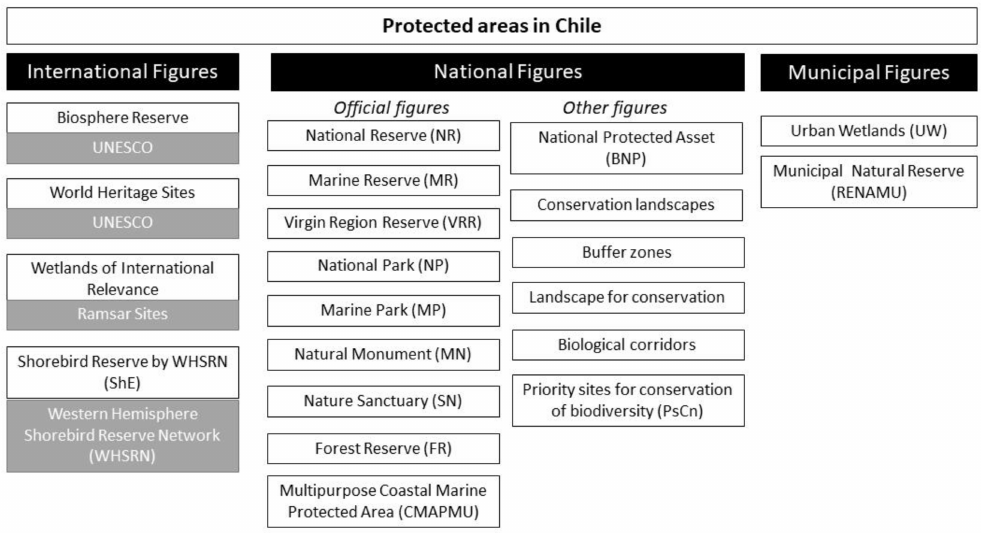
Figure 2. National and international protection categories in